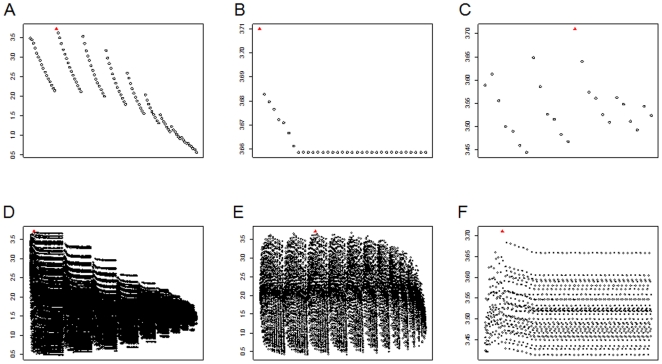
Effect on relative risk (RR) of modifying the ranges of continuous variables.Graphs show RR for all other possible definitions of risk group on the explanatory variables, with equal or greater size than the HyperCube® rule. Y-axis indicates the RR. A) Only ranges of Age are modified: 102 choices among 4,851 possible choices had size equal or greater than 1,689 (size of the HyperCube® rule) and are plotted; B) Only ranges of previous PMIs are modified: 35 choices among 1,035 possible; C) Only ranges of Year are modified: 25 choices among 190 possible; D) Ranges of both Age and previous PMIs are modified simultaneously: 25,040 choices among 5,020,785 possible; E) Ranges of both Age and Year are modified simultaneously: 8,912 choices among 921,690 possible; F) Ranges of both previous PMIs and Year are modified simultaneously: 1,110 choices among 196,650 possible. Filled red triangle represents the RR of HyperCube®'s rule (HyperCube®'s risk group), empty black circles represent the RR of other choices of risk groups.